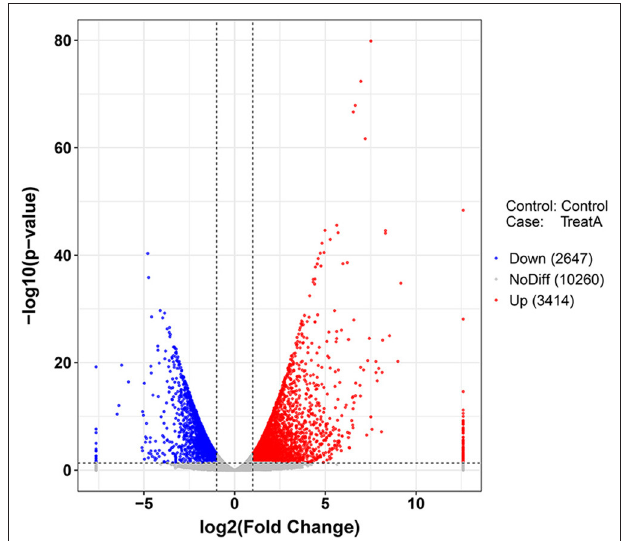
FIGURE 3 | Volcano plot ( p < 0.05) of down-regulated (blue) and up-regulated (red) DEGs expression levels. The blue bar indicates the percent of genes enriched to the transcript factors. The orange bar indicates the reference significance p = 0.05. The red bar indicates the significance of enrichment.